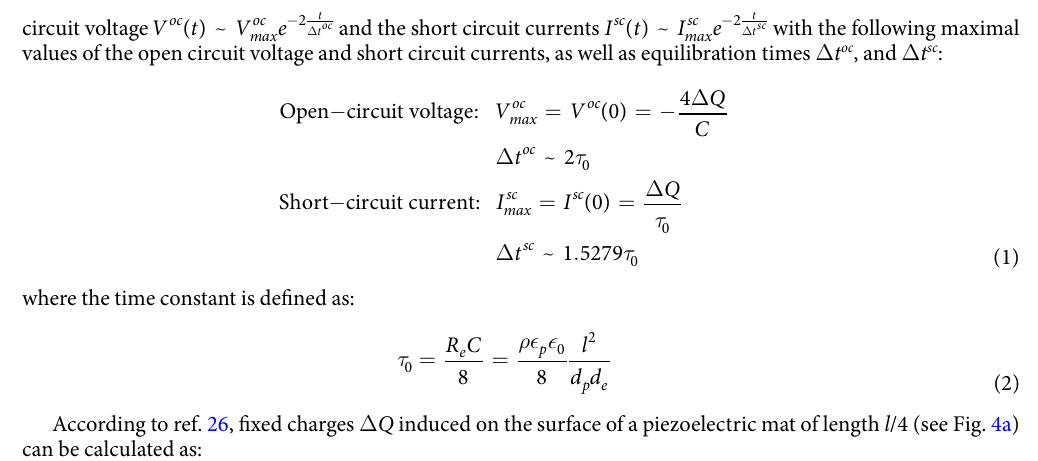
Figure 4. Electrical properties of the laminated piezoelectric generators under bending. ( a ) Schematic of charge separation in the piezoelectric mat under bending. ( b ) Equivalent electric circuit of the generator with a resistance load R L . ( c , d ) The measured output voltages ( c ) and currents ( d ) generated by a laminated generator (BTO concentration: 20 wt%) under different displacements ( ∆ l ) compared to the calculated ones (red lines) using Eq. (6). ( e , f ) The relationship between the output voltage (current) and piezoelectric mat width w ( e ), and piezoelectric mat thickness d p ( f